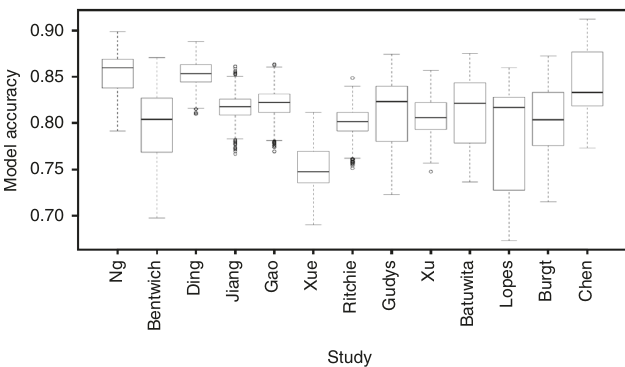
Fig. 1 Classi fi er accuracy distribution. Box-whisker plots showing the accuracy distribution among selected studies for 1000-fold MCCV. The individual accuracy measures of the DT, NB, and SVM classi fi ers were merged to create this plot. Per classi fi er results can be found in Supplementary Figs. 1 –